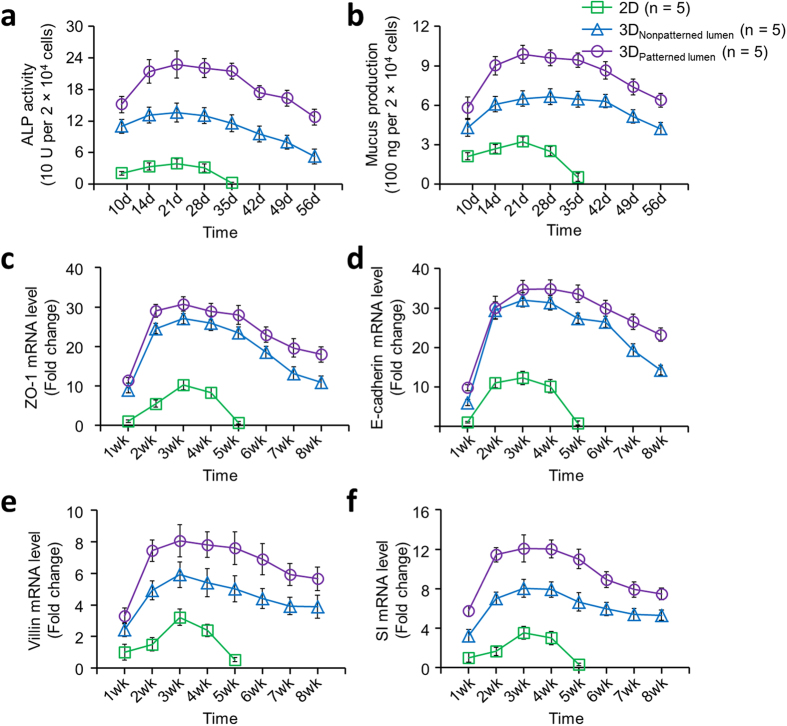
3D architecture and multicellular co-culture system significantly enhanced the overall differentiation level of the epithelial cells and supported longer-term static cultures of intestinal epithelium.(a,b) Quantification of alkaline phosphatase activity (a) and mucus production (b) of intestinal epithelial cells cultured on 2D transwell and 3D silk scaffolds. (c–f) Gene expression levels of cell junction-related genes and intestinal epithelial biomarkers, including ZO-1 (c), E-cadherin (d), Villin (e), and SI (f), were evaluated by quantitative reverse transcription-polymerase chain reaction (qRT-PCR). Data is presented as mean ± SEM, n = 5 in each group, p < 0.001.